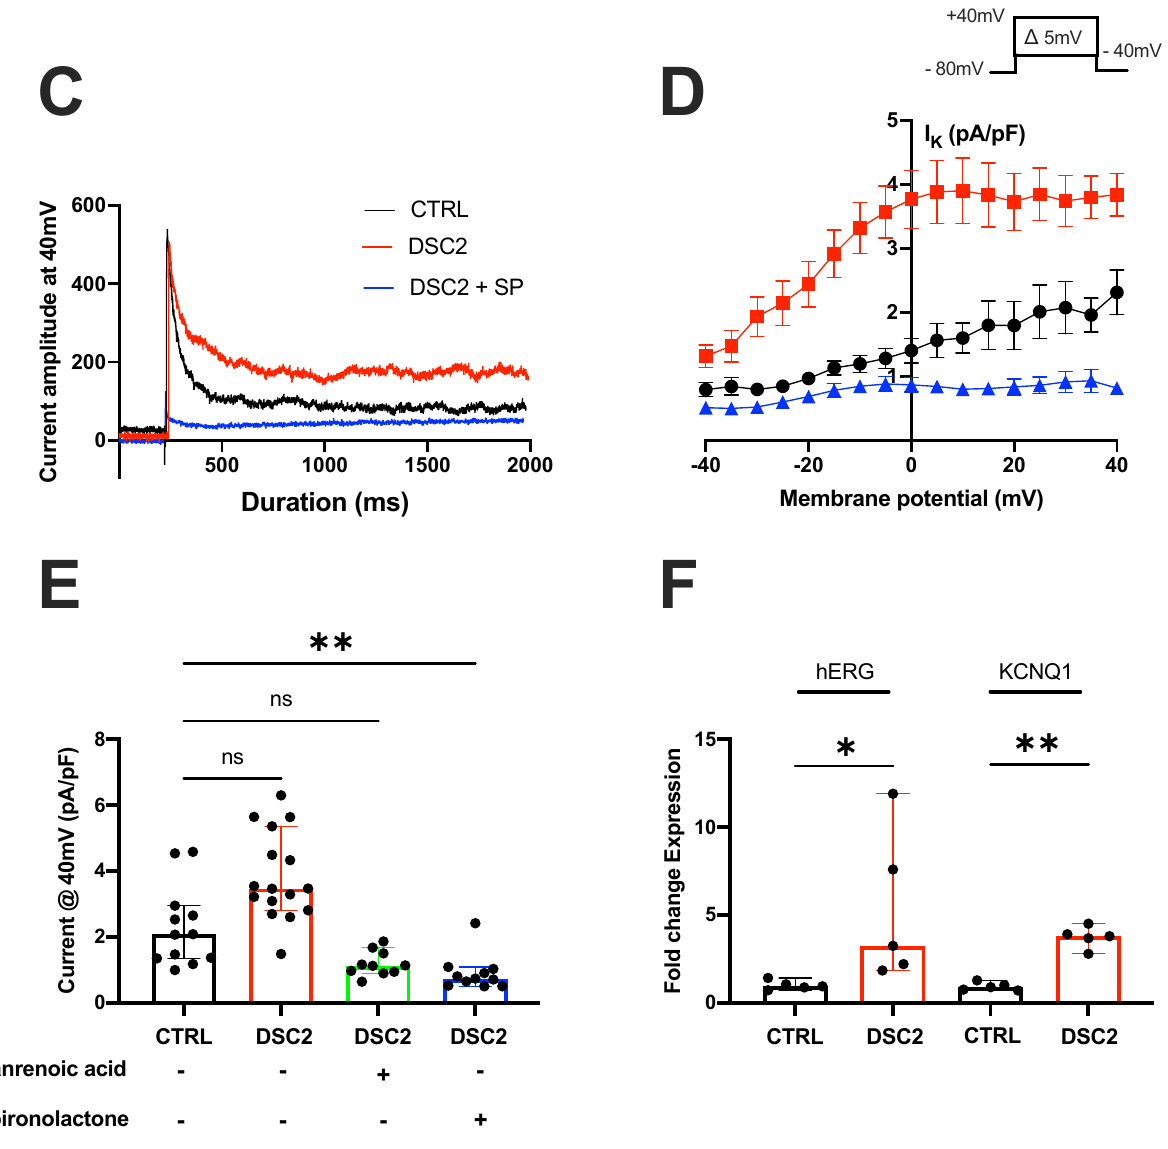
Figure 3. Effect of Canrenoic Acid on Potassium Channels. ( A ) Raw traces of K + currents at +40 mV in control (black), DSC2 (red), and DSC2 + CA (green) condition and ( B ) potential current curves corresponding (CTRL n = 12; DSC2 n = 15; DSC2 + CA n = 10). ( C ) Raw traces of K + currents at +40 mV in control (black), DSC2 (red), and DSC2 + SP (blue) condition and ( D ) potential current curves corresponding (CTRL n = 12; DSC2 n = 15; DSC2 + SP n = 11). ( E ) Values of Current amplitude at 40 mV for the different groups. ( F ) RT-qPCR results of fold change expression for hERG and KCNQ1 gene in CTRL and DSC2 hiPSC − CM. The results are represented with the median and 95% confidence interval. The stars * correspond to the difference from the control. ns not statically significant, * p < 0.05, ** p < 0.01 (Kruskal–Wallis